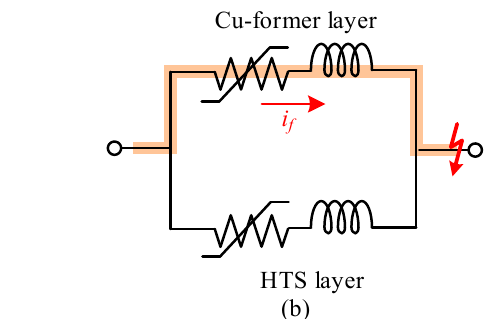
Figure 2. Operation characteristics of the HTS cable: ( a ) current flow into each phase in the normal state; and ( b ) current flow into each phase in the transient state.